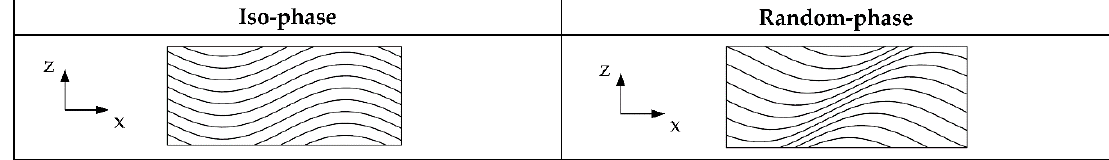
Figure 31. Embedded vs. visible waves. 5.5. Dimensional Characteristics With regard to the assessment of fiber waviness, the dimensional characteristic of waves is an important distinguishing feature. If the waviness changes one of its characteristics in the third spatial direction, this must also be taken into account. Figure 32 shows a representation of a 2D wave (left) and a 3D wave (right). Figure 32. 2D vs. 3D waves. The analytical description for uniform waviness in 2D, based on [13], is expanded for 3D waviness and the spatial position of the fiber v and the fiber angle θ can be written as: 𝑣 = 𝐴 2 ∗ 𝑦 𝑤 ∗ (cid:3428)1 − cos (cid:3436)2 ∗ 𝜋 ∗ 𝑥 𝐿